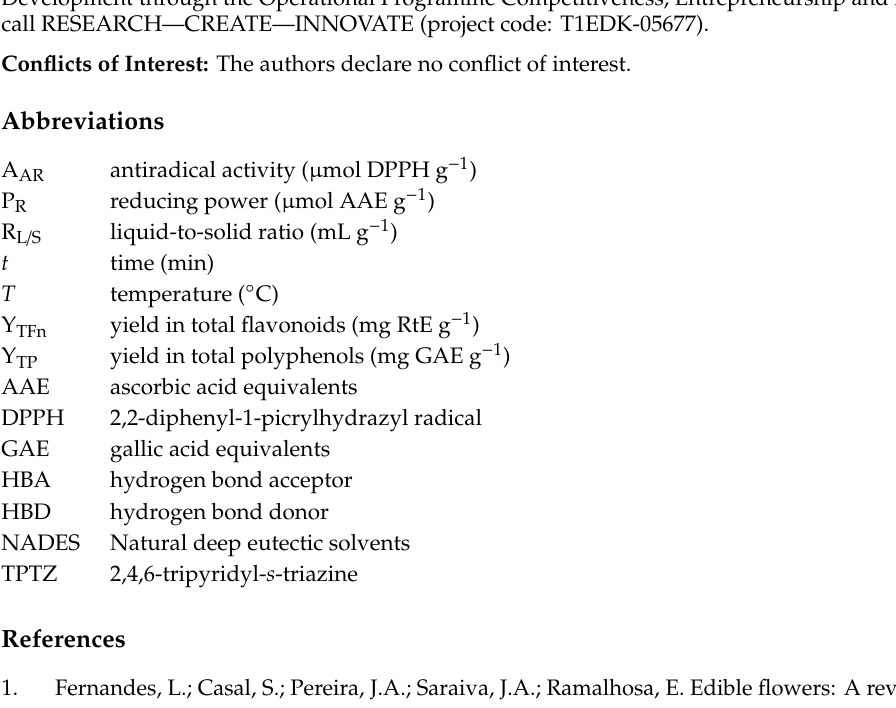
Supplementary Materials: The following are available online, Figure S1: Total ion chromatogram showing all peaks tentatively identified in the EBF extract obtained under optimized conditions, at 80 ◦